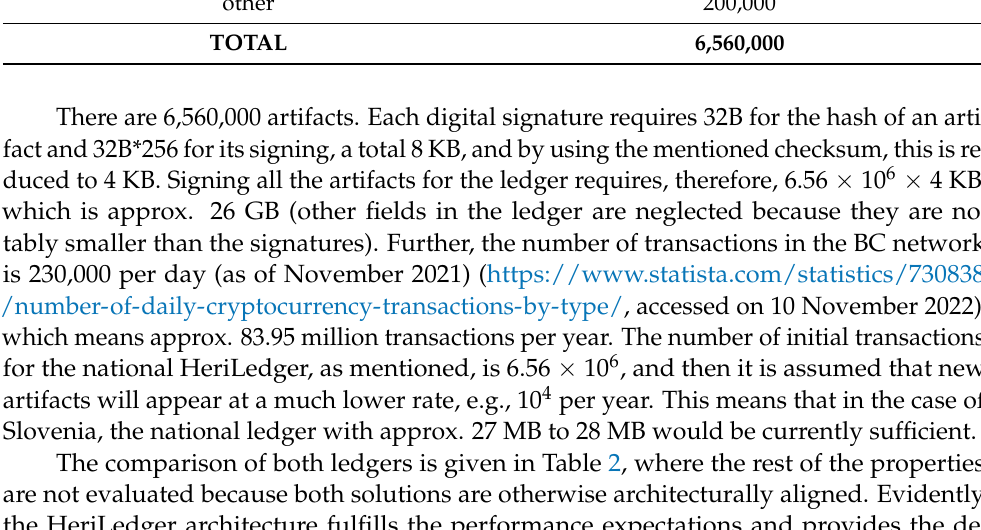
Table 1. Numbers of cultural heritage artifacts in Slovene museums.